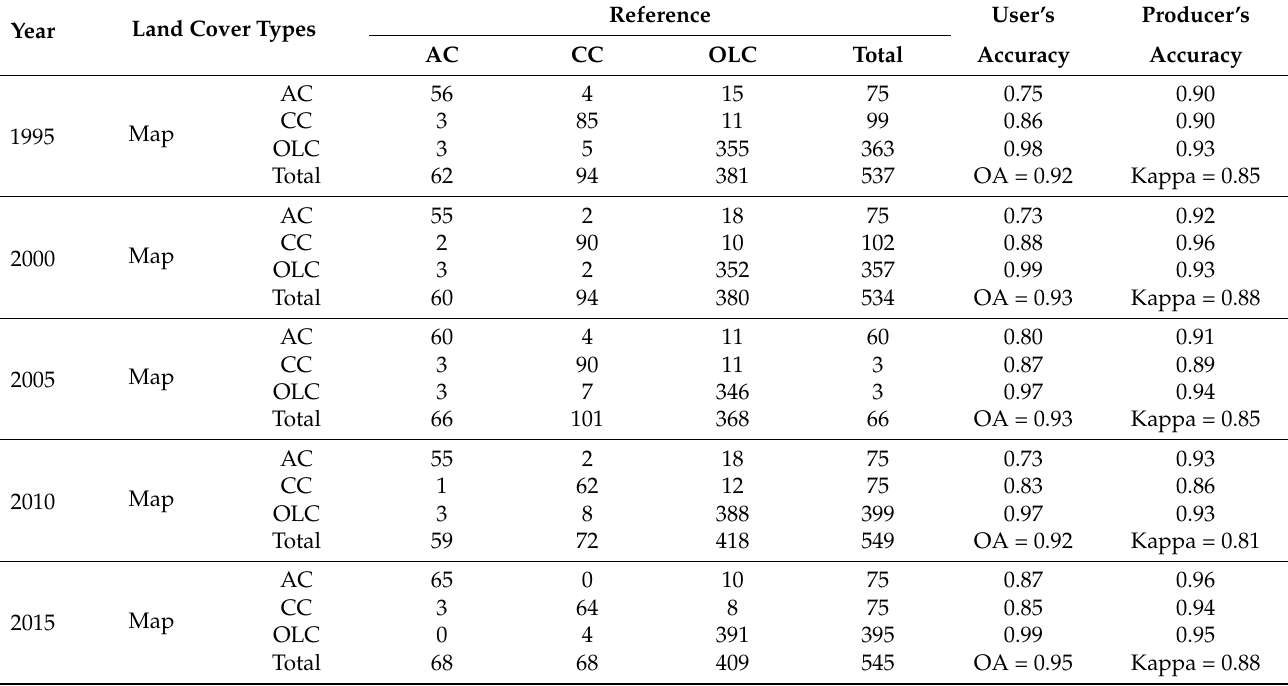
Table 3. Accuracy assessment of the cropland abandonment maps for study area in 1995, 2000,